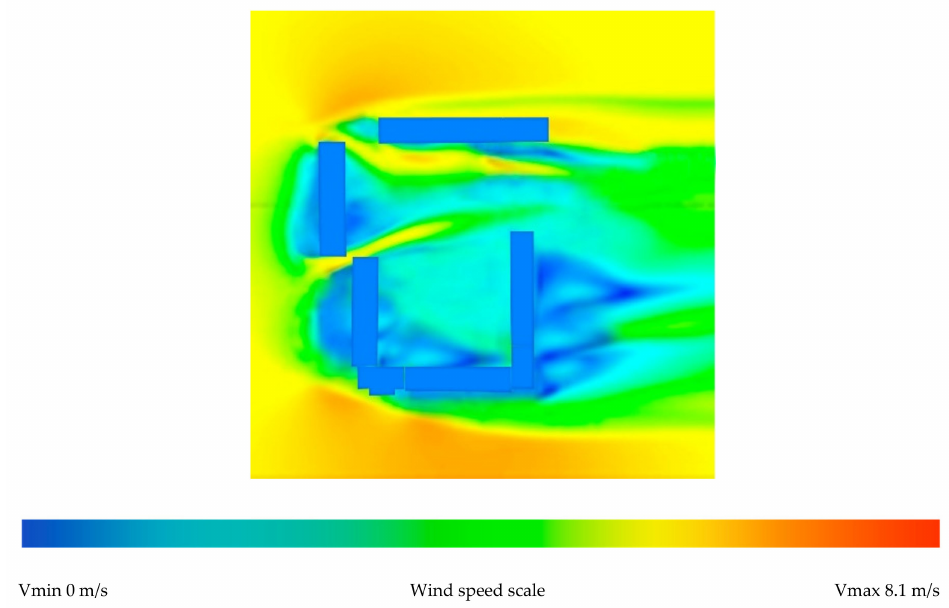
Figure 10. Velocity fields for the real residential perimeter block in Murmansk